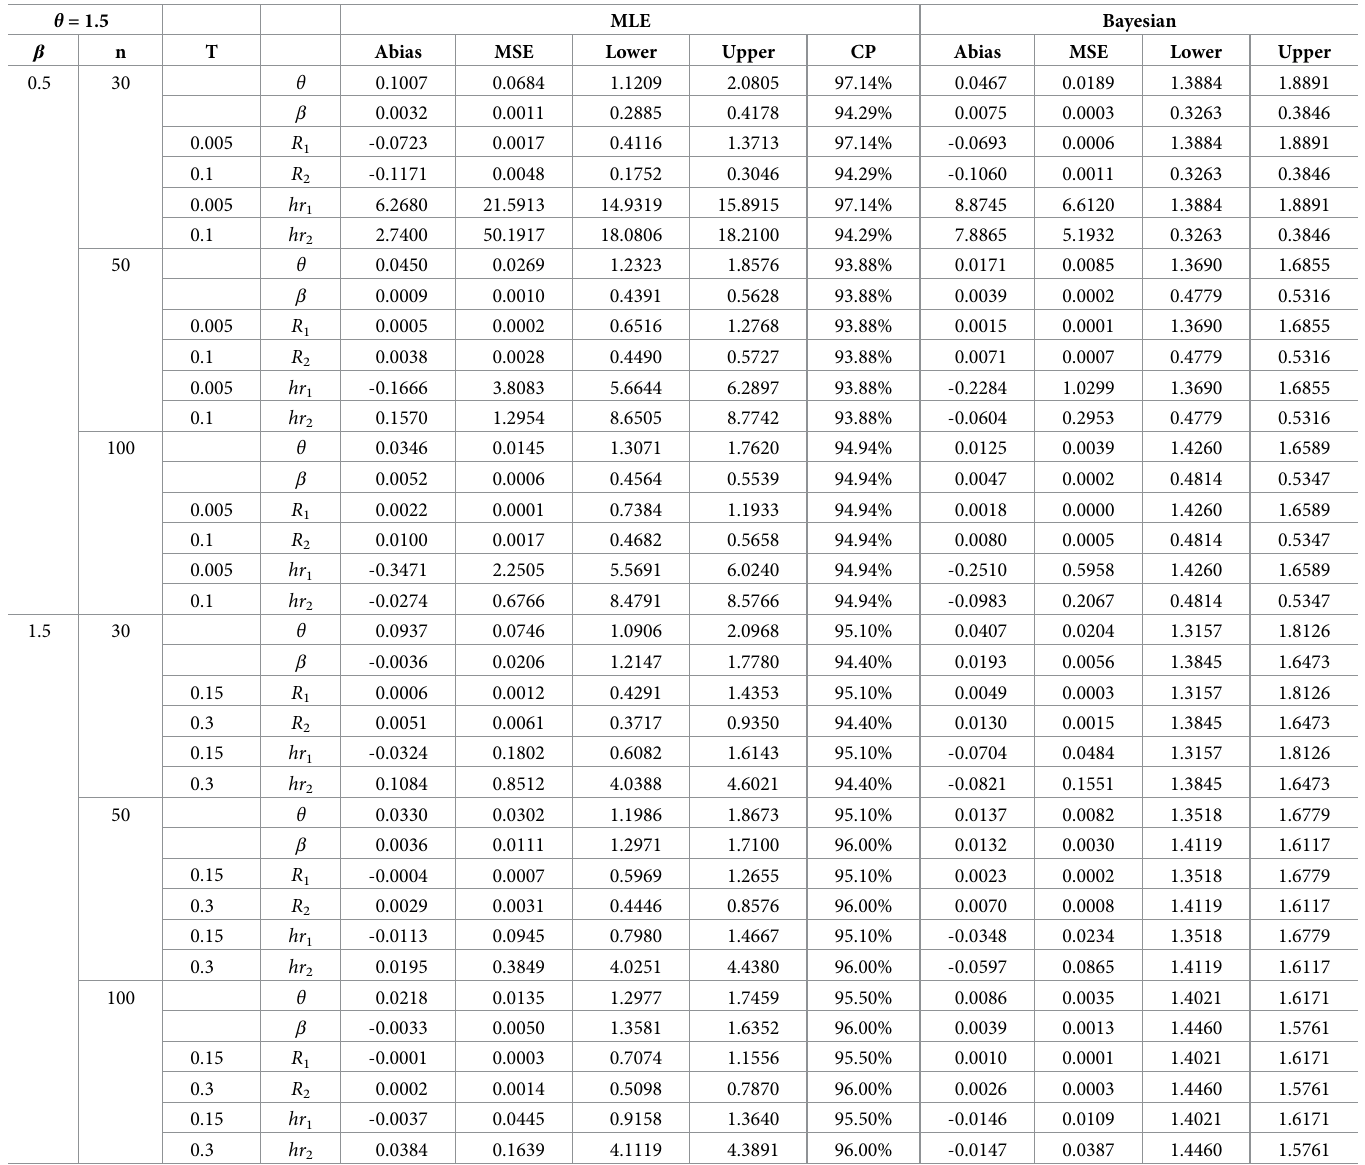
Table 2. Simulation results when the value of θ = 1.5. θ =